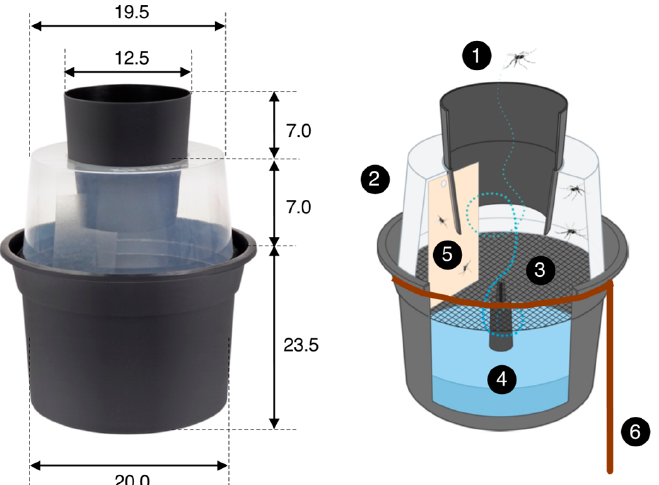
Figure 4. The Gravid Aedes Trap (or BG-GAT trap) is a passive trap that collects mosquitoes ready to lay their eggs. Female mosquitoes enter the trap through a black cone (1) and enter into a translucent chamber (2). A black nylon screen (3) separates the chamber from the oviposition substrate (4) (water with some organic material, e.g., some leaves). Unable to land on the water surface, mosquitoes fly around in the translucent chamber, where they collide with or land on a sticky card (5) (size 8 × 14 cm) on which they become trapped. A rebar wire (diameter 6 mm) ring with a peg (6) was used to position the trap solidly on the ground and prevent it from falling over. All dimensions are in cm. See Eiras et al. [23] for further details; image source: Biogents AG, Germany.